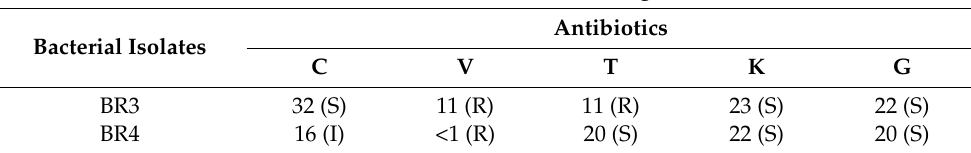
Figure 3. Antibiotic sensitivity profile of BR3 and BR4 on Mueller–Hinton agar plates. Letters on the discs represent antibiotics: C: chloramphenicol (30 µg/disc), V: vancomycin (30 µg/disc), T: tetracycline (30 µg/disc), K: kanamycin (30 µg/disc), and G: gentamicin (10 µg/disc). The inner diameter of the medium holding plate measures 86 mm. Table 1. Antibiotic sensitivity profile of bacterial isolates BR3 and BR4. Diameter (mm) of the Zone of Inhibition Following 24 h of Incubation